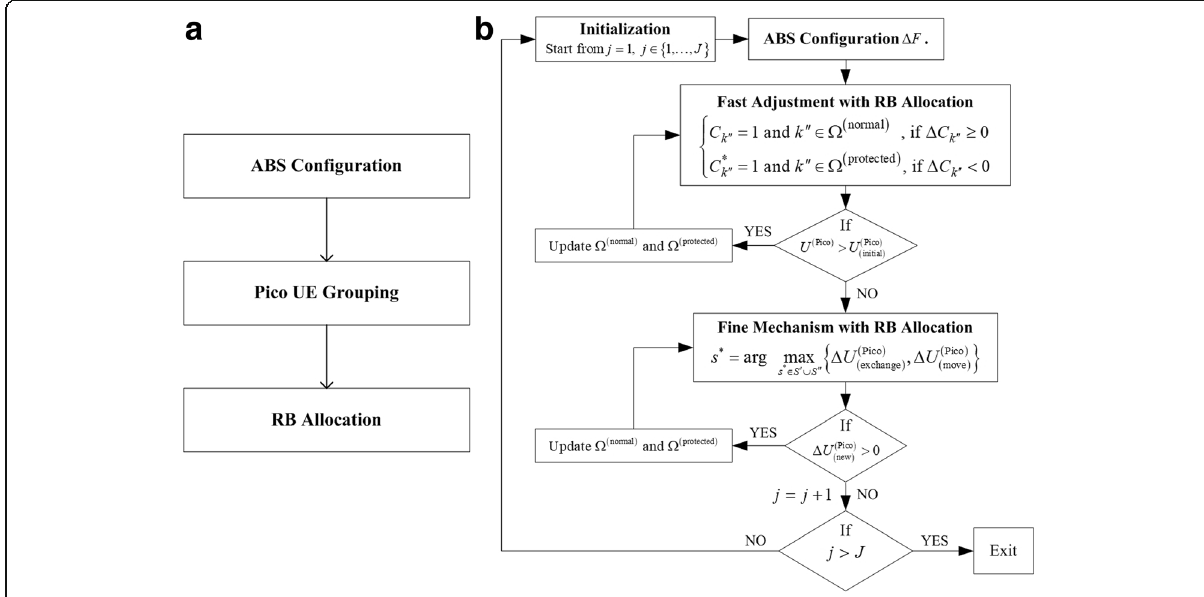
Fig. 2 a Flow chart of the proposed joint allocation scheme. b Procedures of the proposed joint allocation